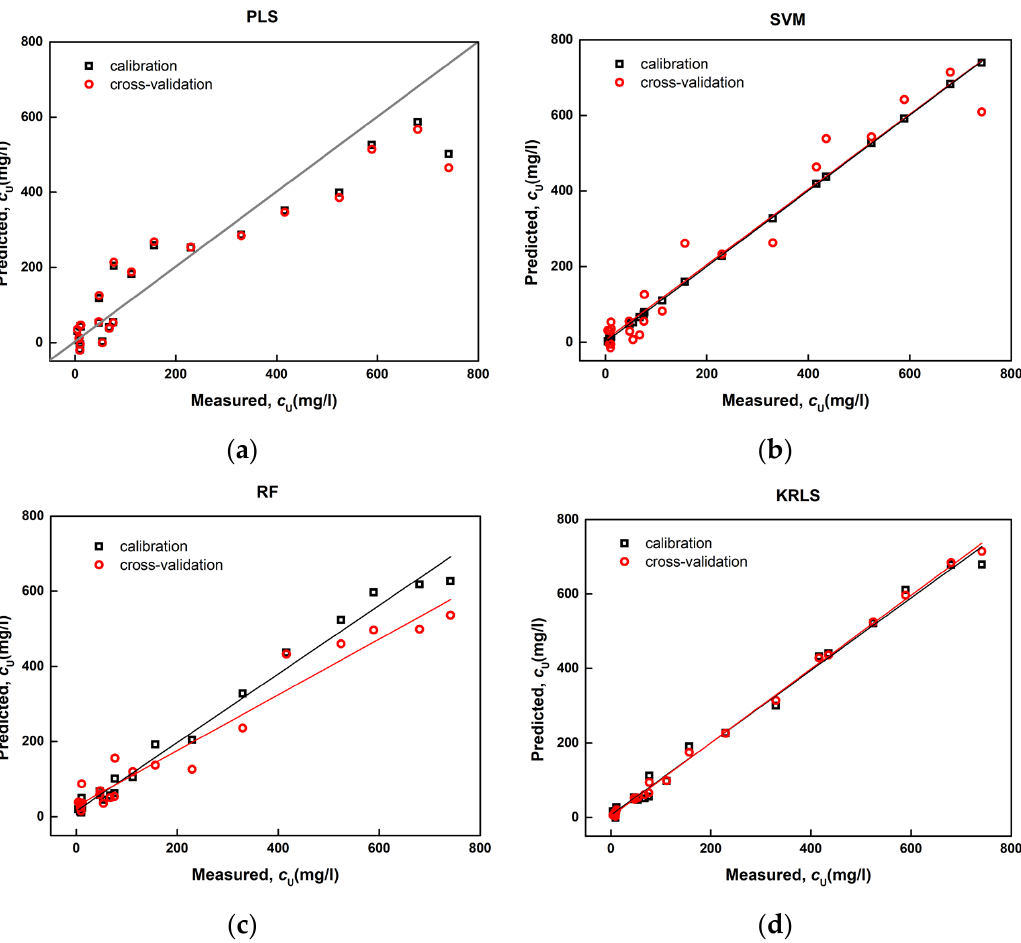
Figure 2. The “measured vs predicted“ plots for PLS ( a ), SVM ( b ), RF ( c ), and KRLS ( d ) models obtained with full cross-validation.